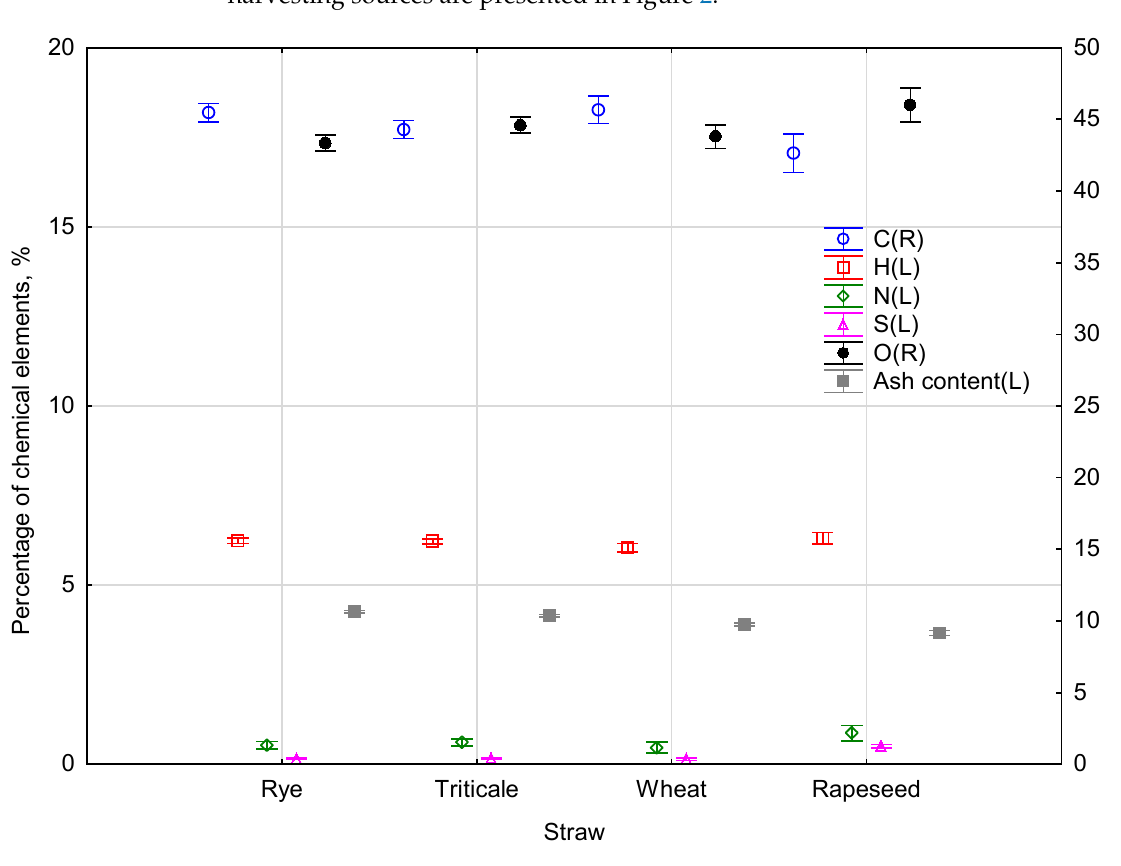
Table 5. Chemical composition of the straw from various sources of